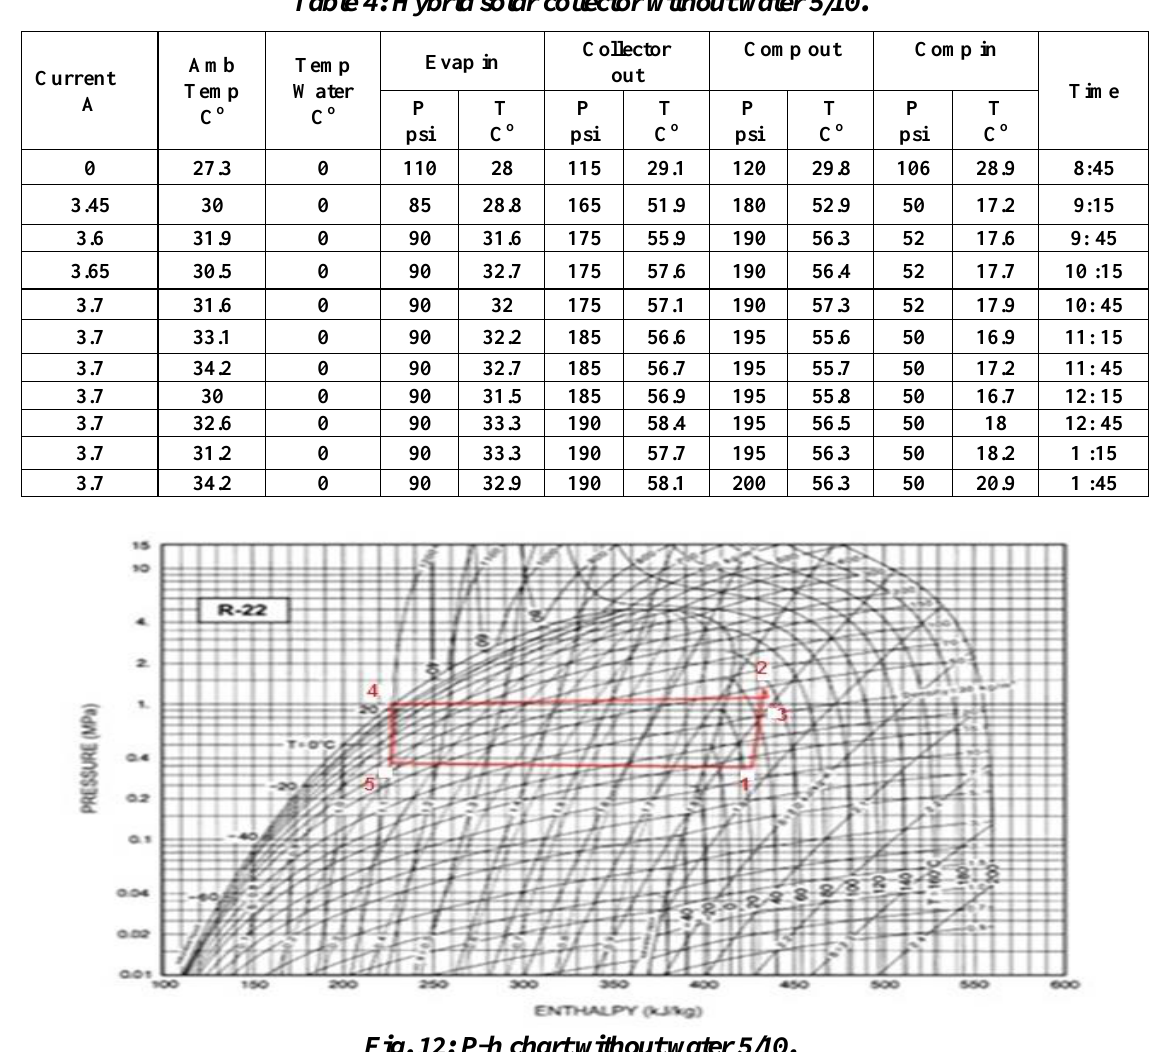
Fig. 12: P-h chart without water 5/10. Table 5: Hybrid solar collector without water